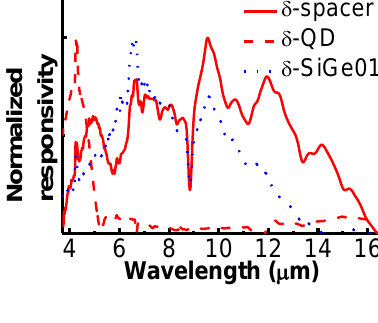
Figure 26. Spectral responses of the MIS SiGe/Si quantum dot (well) infrared photodetectors at 15 K. For the spacer sample, the detection regions of 3.7–6 and 6–16  m corresponded to the LH1-to-LH3 transition in QDs, and intraband transitions in the boron doping wells, respectively